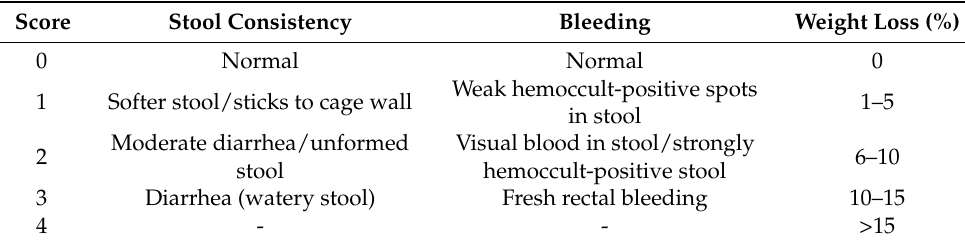
Table 1. Standard of the disease activity index (DAI)